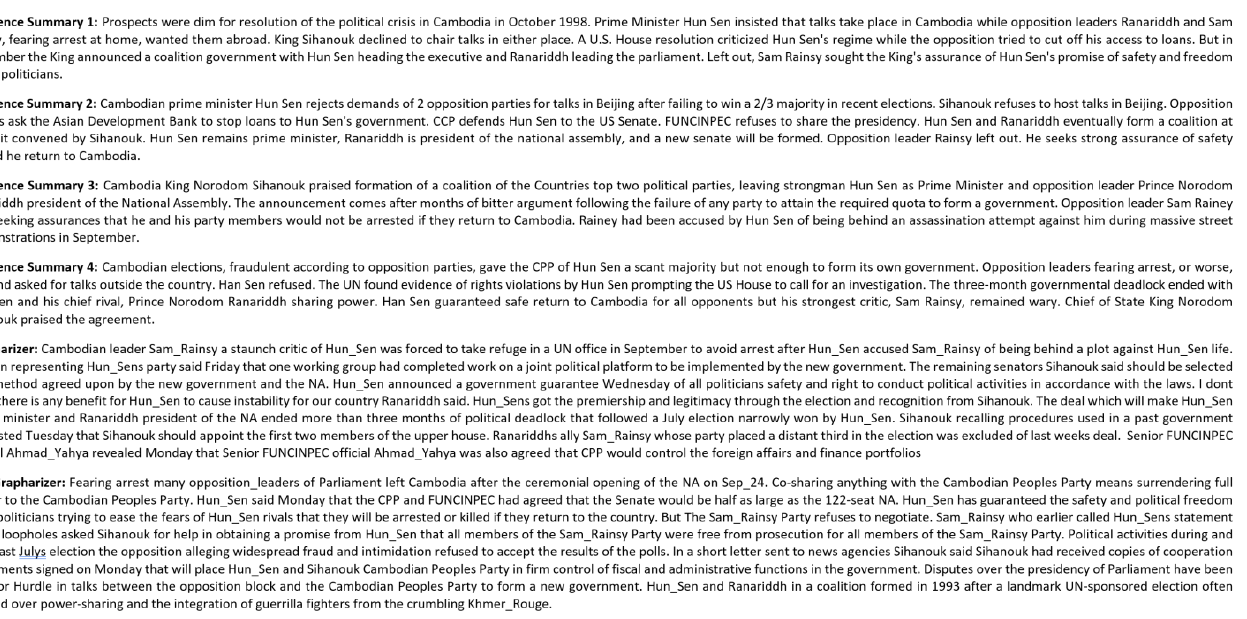
Figure 6. Four reference summaries from DUC 2004 and summaries generated by Grapharizer and ML variant.